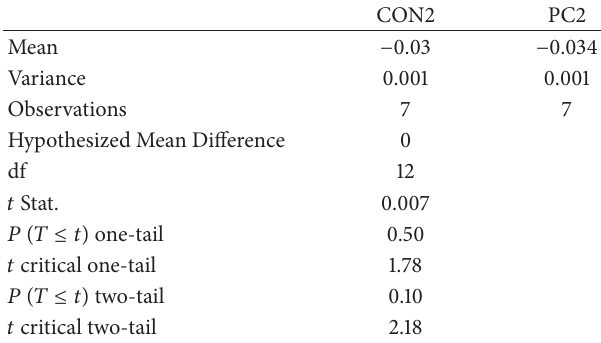
Table 6: 𝑡 -test assuming unequal variance, total shrinkage.